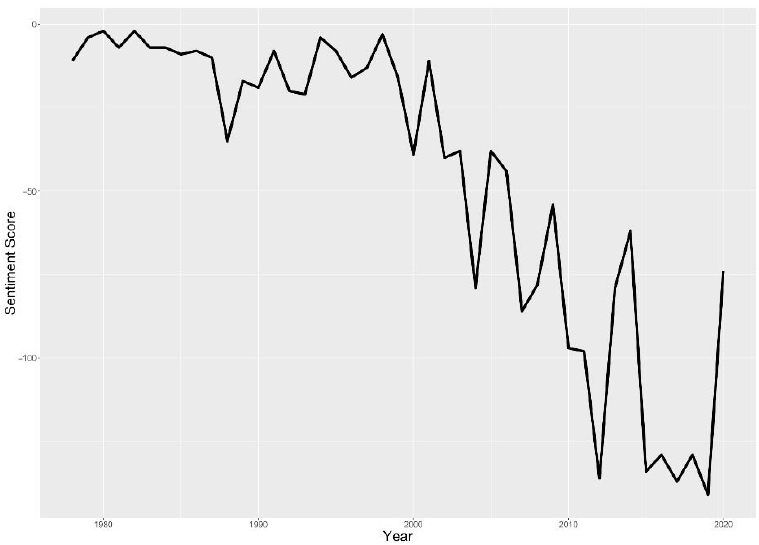
Figure 6. Yearly trend in negative sentiment from AFINN lexicon sores.